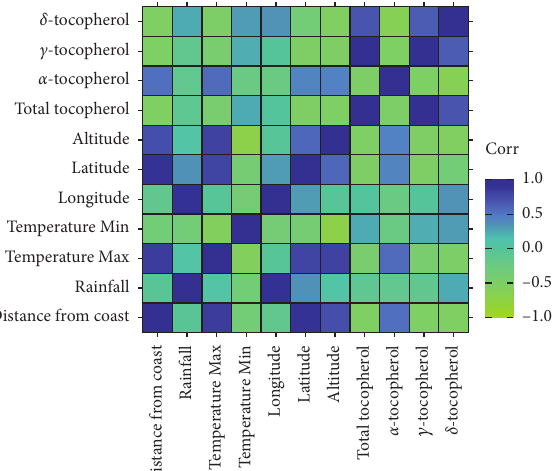
Figure 3: Heatmap of Pearson’s correlation coefficient between tocopherol homologues and geographical parameters.